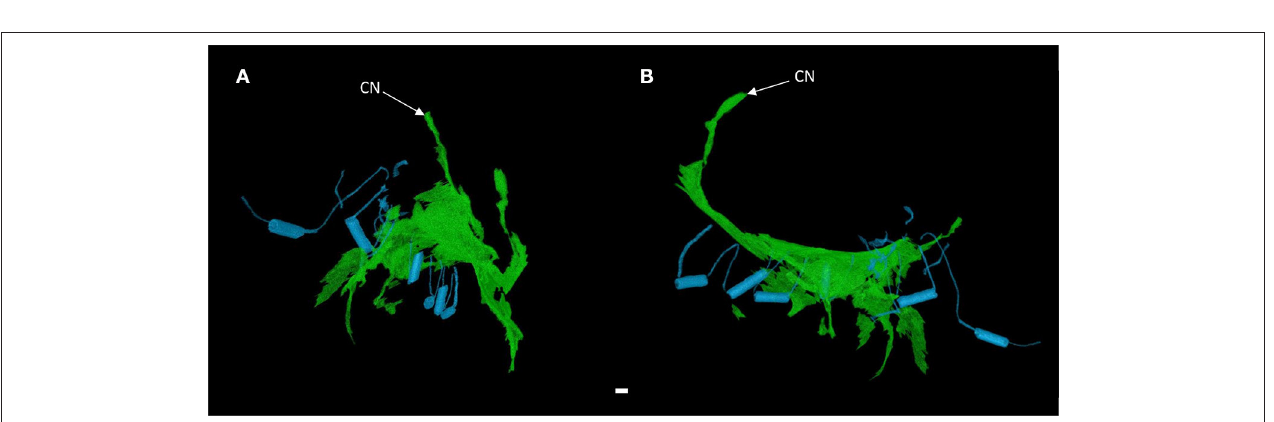
FIGURE 3 | Virtual histology of the cardiac conduction system in a heart with atrioventricular septal defect (AVSD). (A) Volume rendering of the whole heart illustrating the virtual cutting planes used in (B–D) . (B) Short axis micro-CT section of the sinus node, (C) two-chamber micro-CT section of the compact atrioventricular node, (D) 4-chamber micro-CT section of the atrioventricular conduction axis. AVCA, atrioventricular conduction axis; CN, compact atrioventricular node; CS, coronary sinus; CT, terminal crest; LV, left ventricle; MS, muscular ventricular septum; RV, right ventricle; SN, sinus node; solid arrow heads- pledget and suture line. Scale bars represents 1mm.